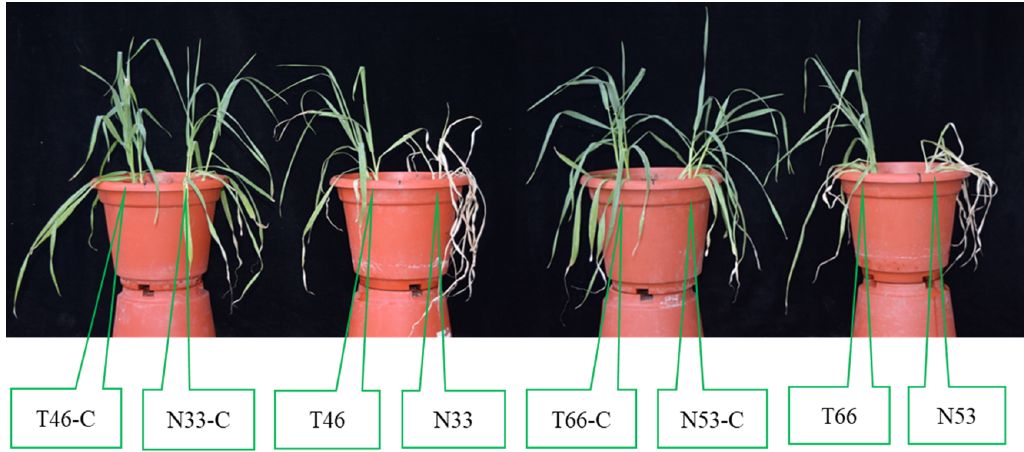
Figure 2. Performance of NILs treated with 300 mM NaCl for 10 days. Control plants (C) were treated with tap water.